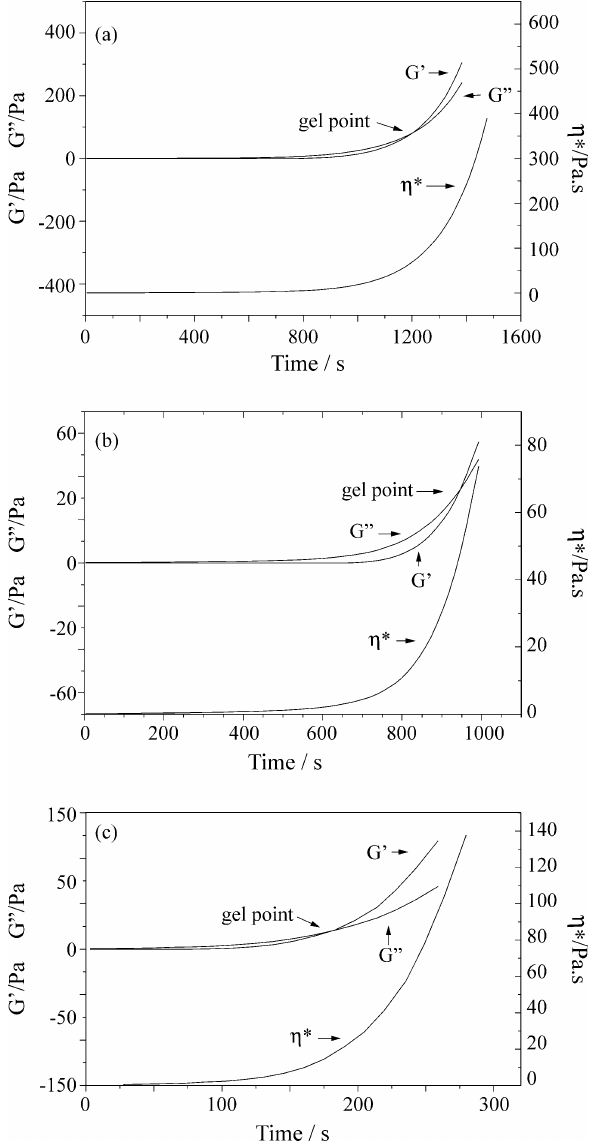
Figure 2. Isothermal rheograms: a) of the furfuryl resin at 50 °C; b) at 60 °C and c) 70